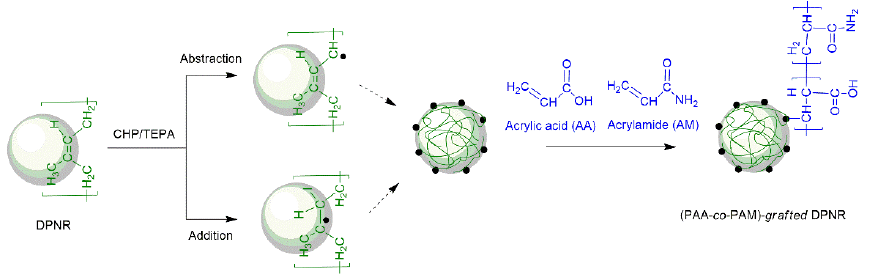
Figure 1. Schematic representation of preparing the (PAA- co -PAM)- grafted DPNR by graft copoly- merization.